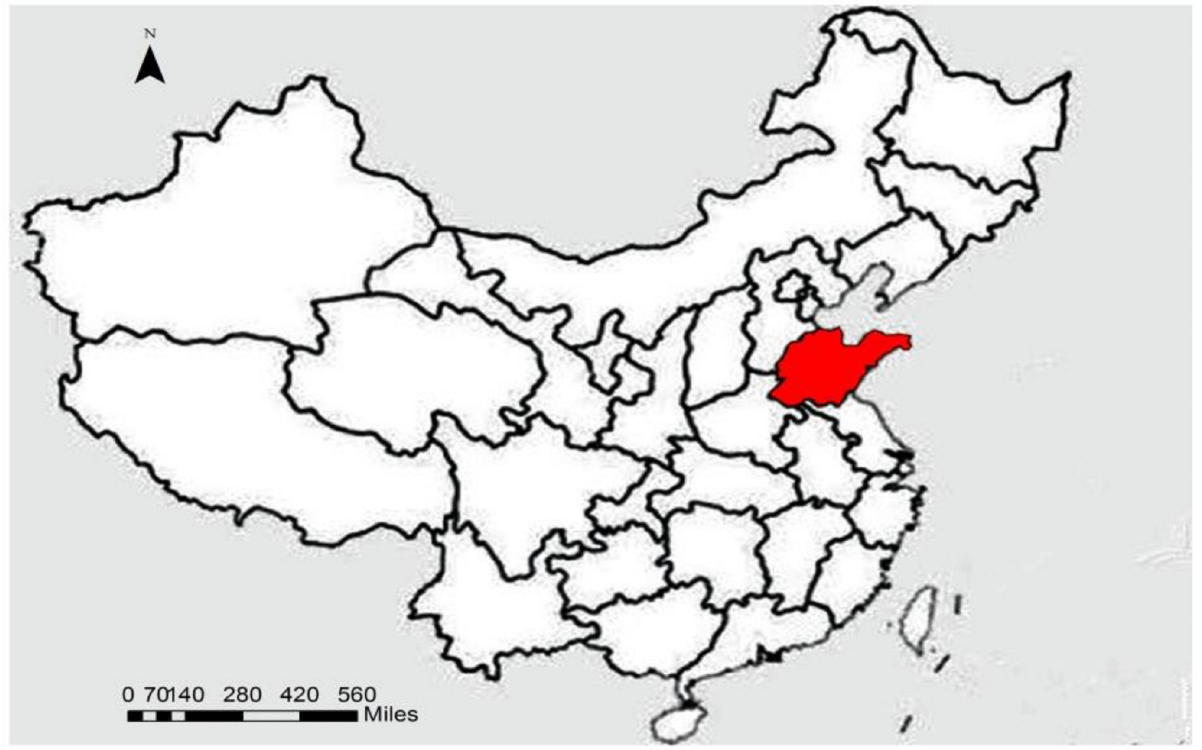
Fig 1. A map of the study area and sample